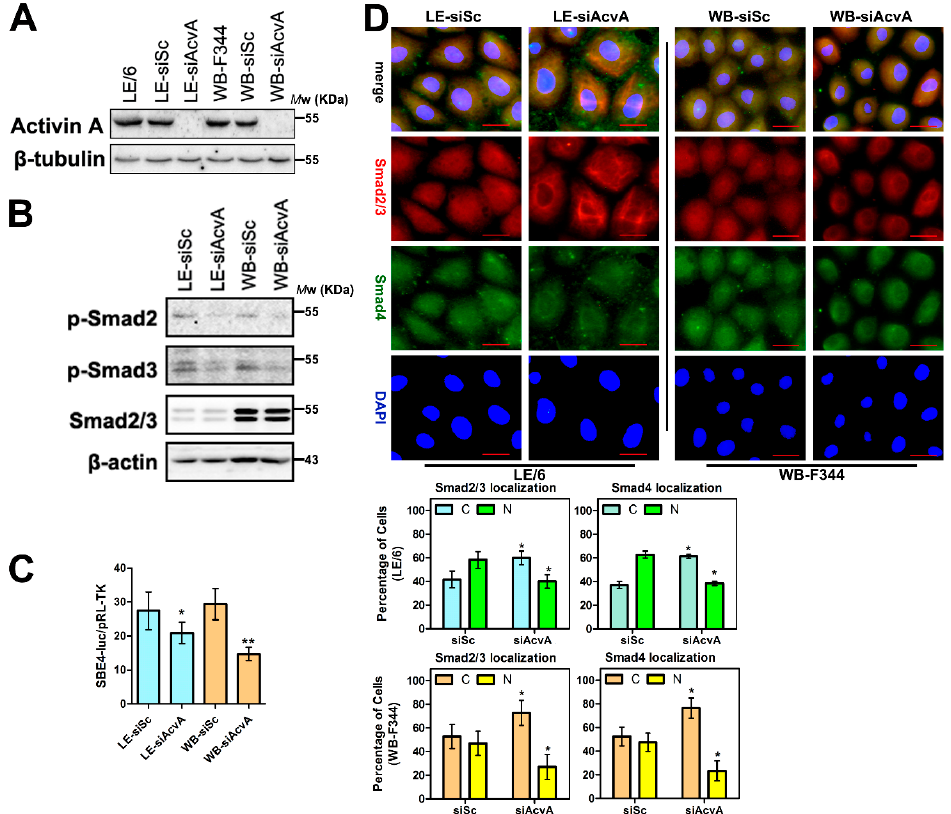
Figure 4. Knock down of Activin A in LPCs causes reduced activity of Smad signaling. ( A , B ) LE/6 and WB-F344 cells were transfected with siRNA duplexes against Activin A (WB-siAcvA or LE-siAcvA cells) or scramble siRNA (WB-siSc or LE-siSc cells), Lysates were subjected to Western blot analyses with antibodies against indicated proteins. β -Tubulin ( A ) or β -actin ( B ) was used as a loading control; ( C ) LE-siSc /LE-siAcvA or WB-siSc /WB-siAcvA cells were co-transfected with pRL-TK and SBE4-luc. Luciferase activity was normalized to renilla luciferase activity and expressed as the means ± S.E.M. of triplicate measurements. * p < 0.05, compared with their control group (siSc), respectively; and ( D ) Upper panel : LE-siSc /LE-siAcvA or WB-siSc /WB-siAcvA cells were subjected to double immunofluorescent staining of Smad2/3 (red) and Smad4 (green). DAPI were used to show the location of the nucleus (blue); scale bar, 20 μ m; Lower panel : quantification of cells that showed Smad2/3 ( left ) and Smad4 ( right ) cytosolic (C) and/or nuclear (N) staining. * p < 0.05, compared with their control group (siSc), respectively.